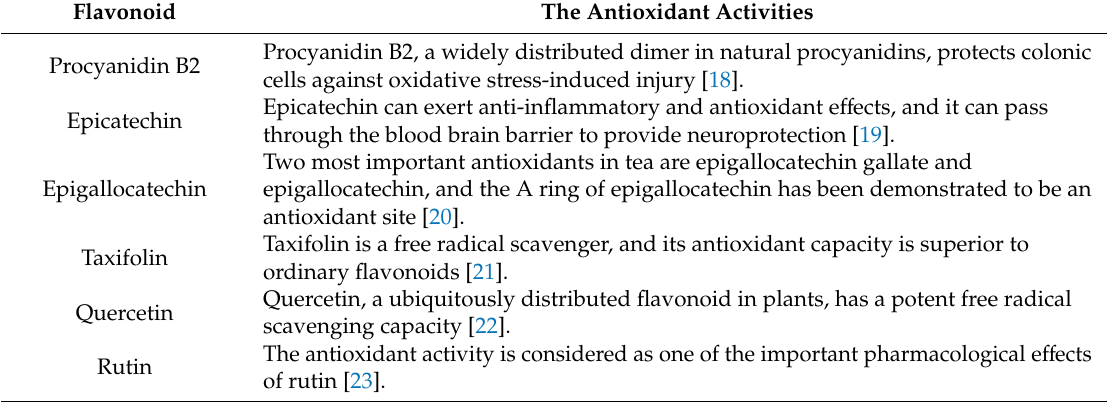
Table 1. The antioxidant activities of procyanidin B2, epicatechin, epigallocatechin, taxifolin, quercetin, and